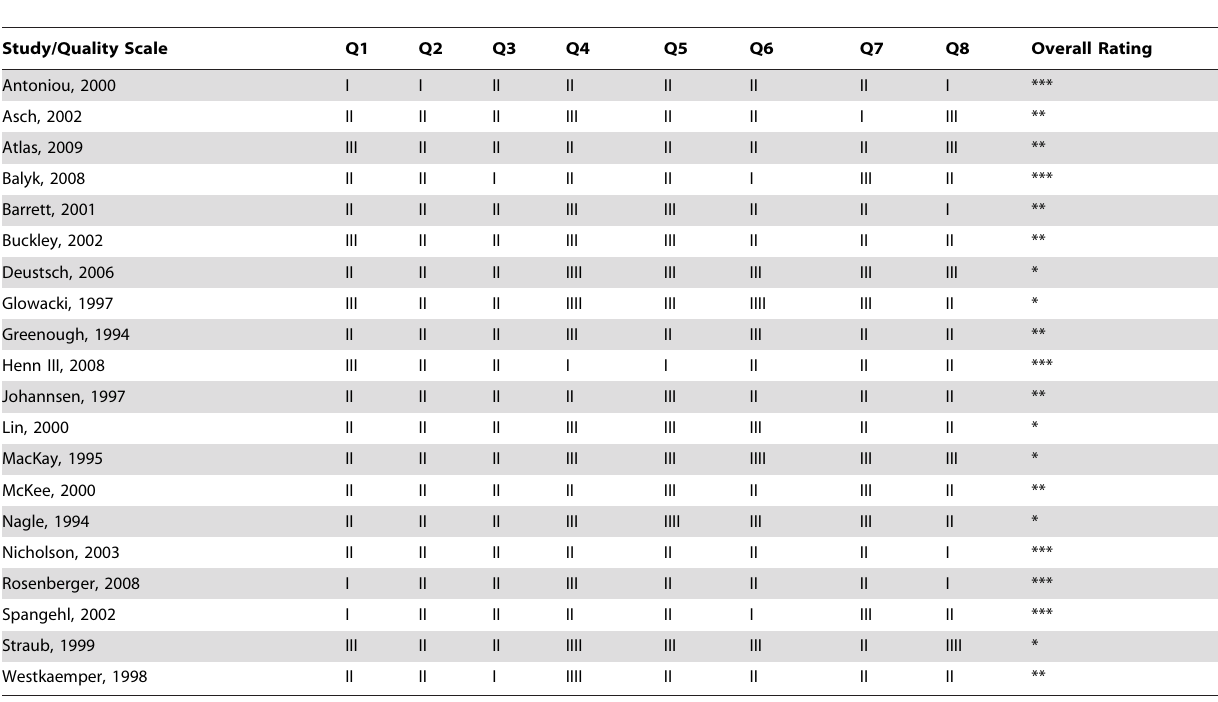
Table 2. Quality